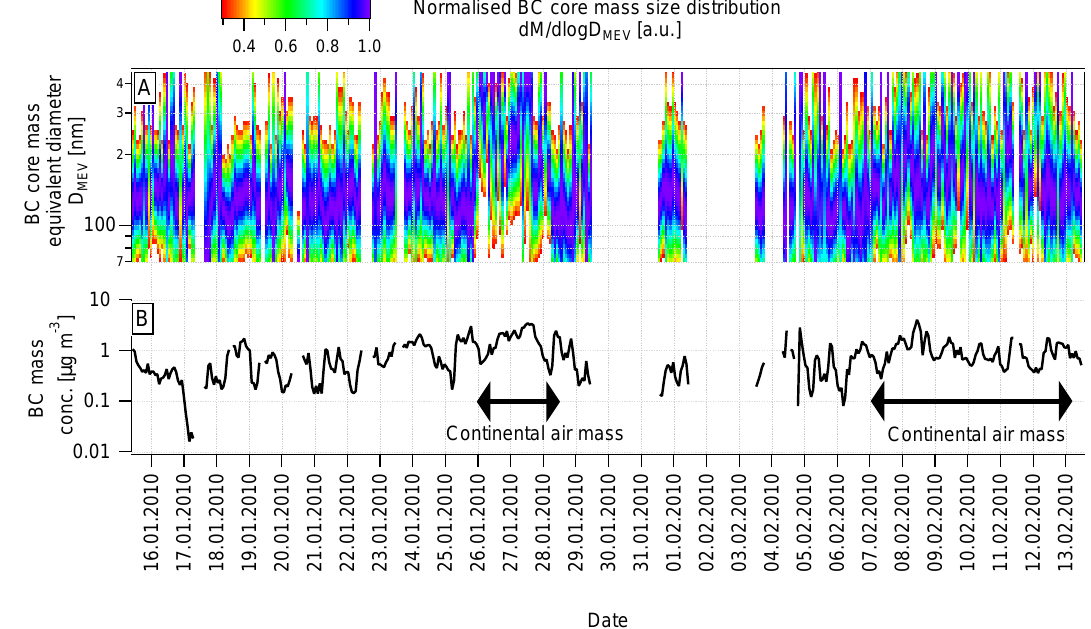
Fig. 6. (A) BC mass size distribution (normalised to its maximum), as measured by the SP2. (B) BC mass concentration as measured by the